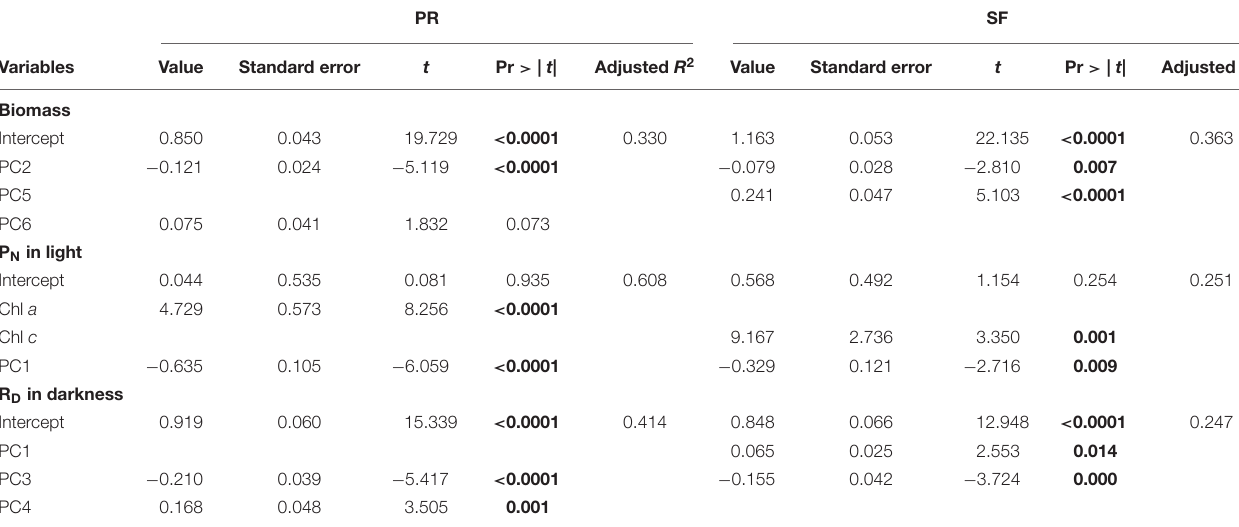
TABLE 2 | Multiple linear regression analysis of chlorophyll a , P N in light, and R D in darkness against the component variables obtained from the PCA analyses of the environmental variables for the Puerto Real (PR) and San Fernando (SF) transects.